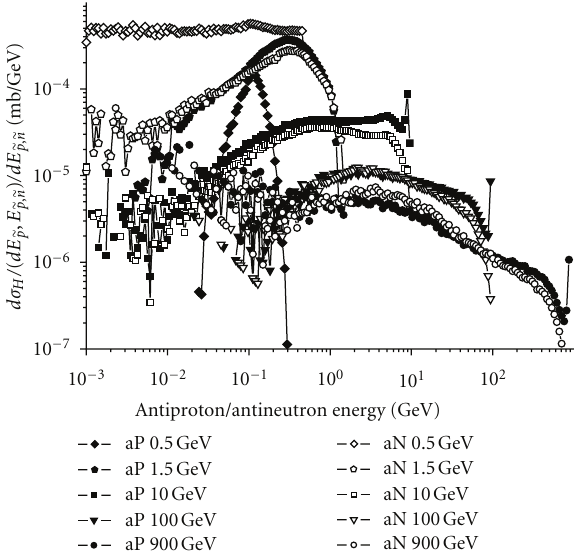
Figure 3: Antiproton and antineutron di ff erentia cross-section of (cid:2) p + H reaction simulated with the MSDM code.